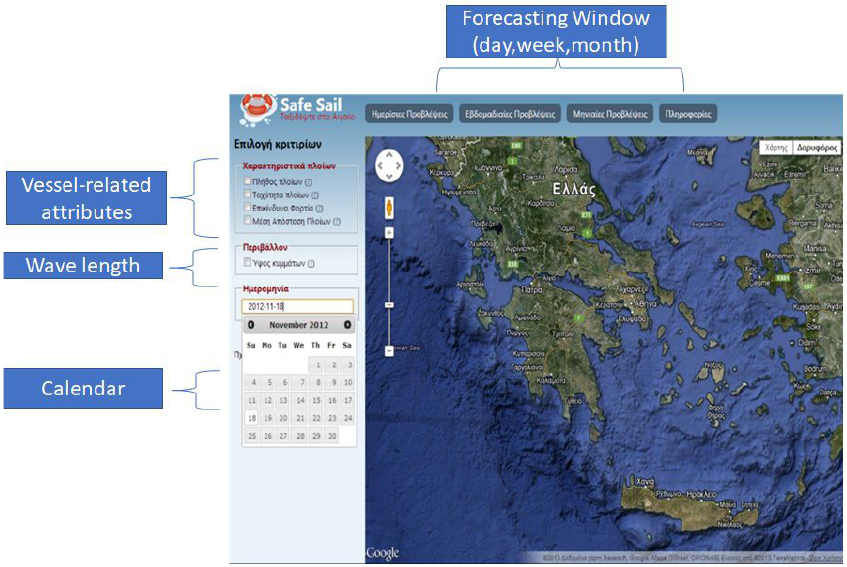
Figure 5. The web user